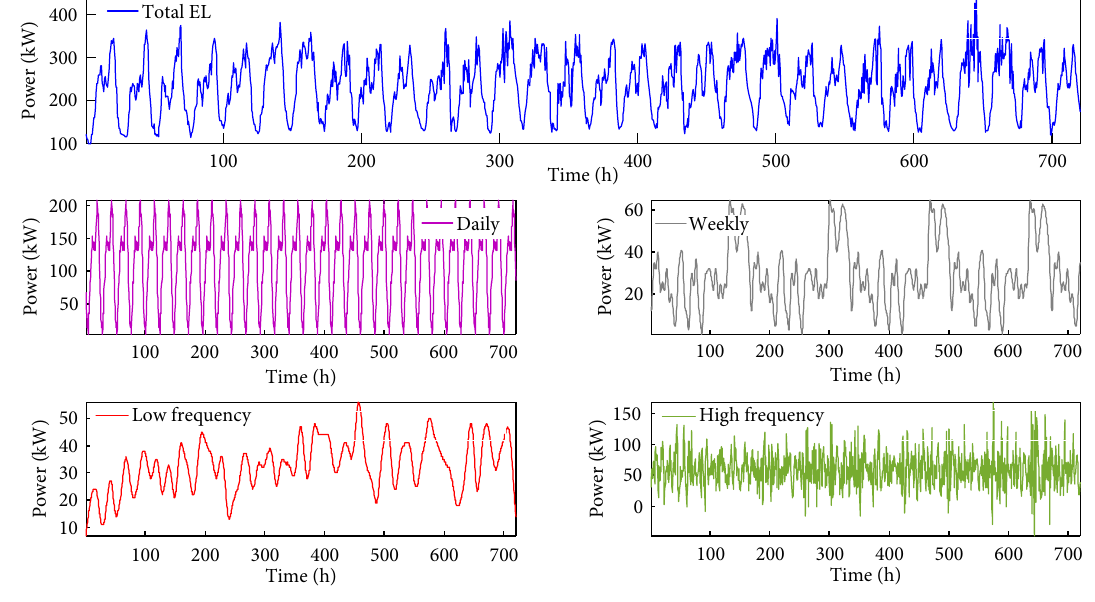
Fig. 7 The result of loads